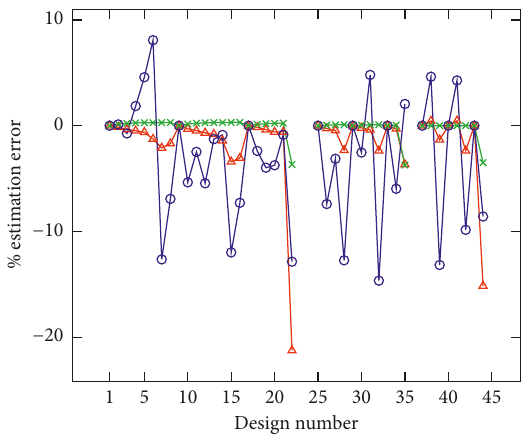
Figure 11: The estimation percentage error for power consump- tion when compared to the measured values.